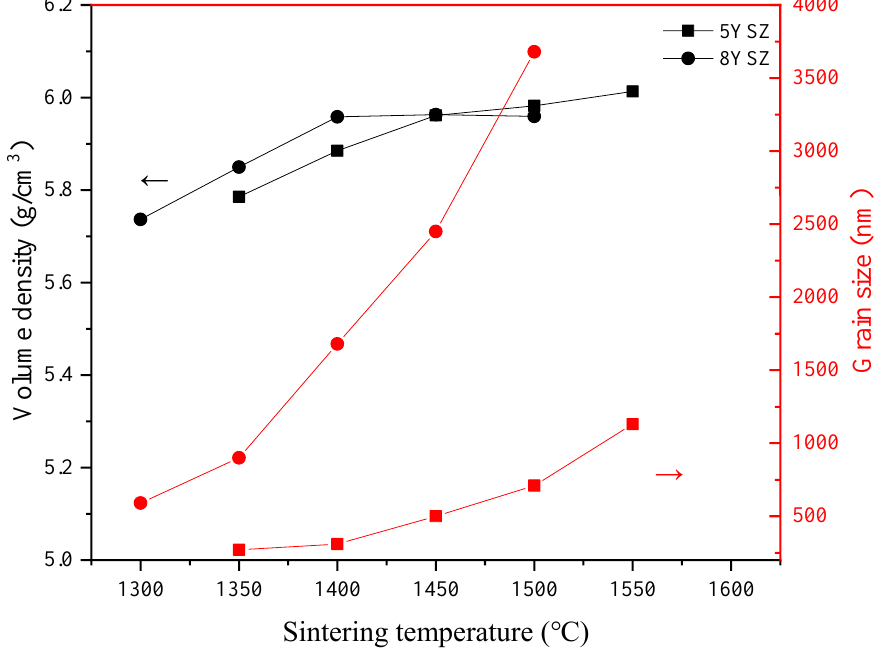
Figure 2. Density and grain size sintered in CS process.